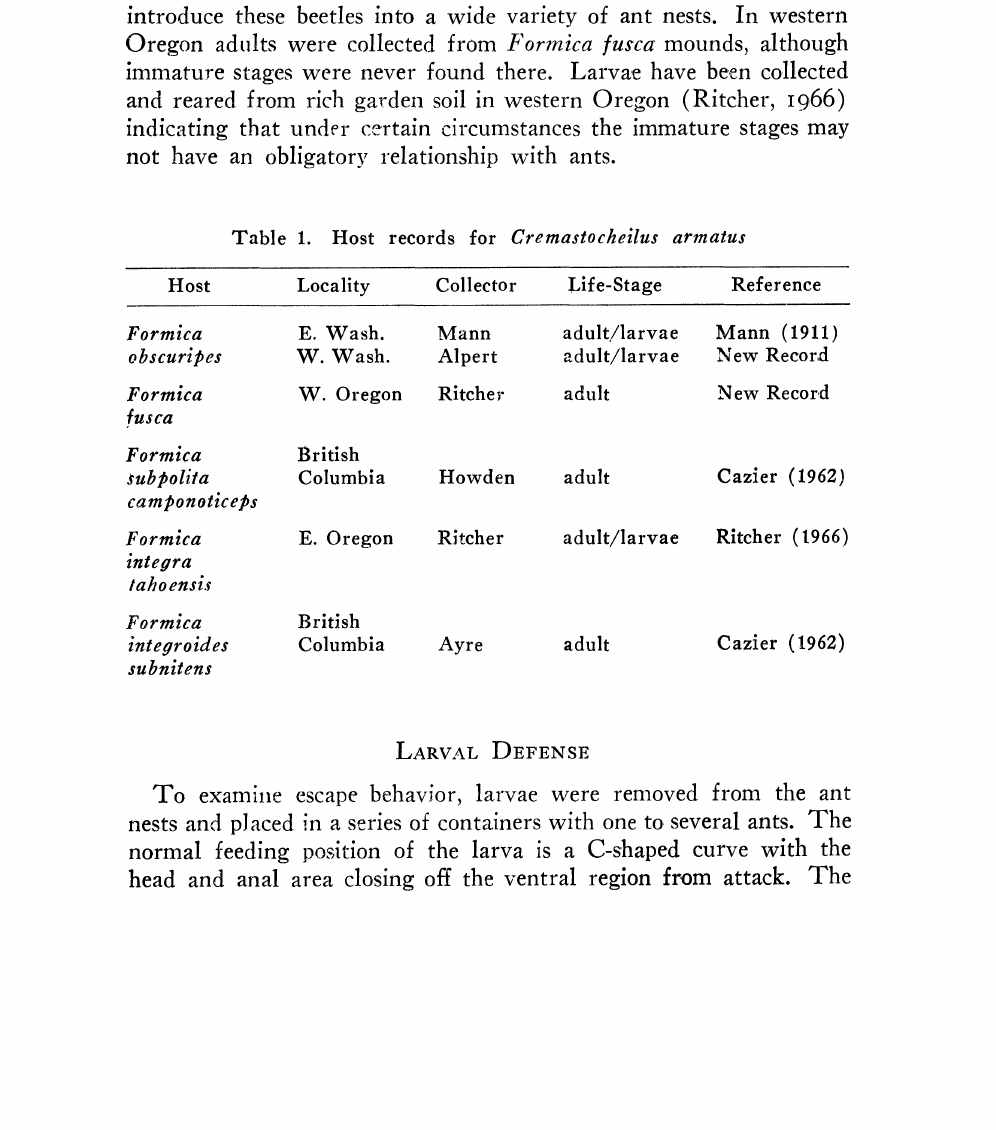
Table 1. Host records for Cremastocheilus